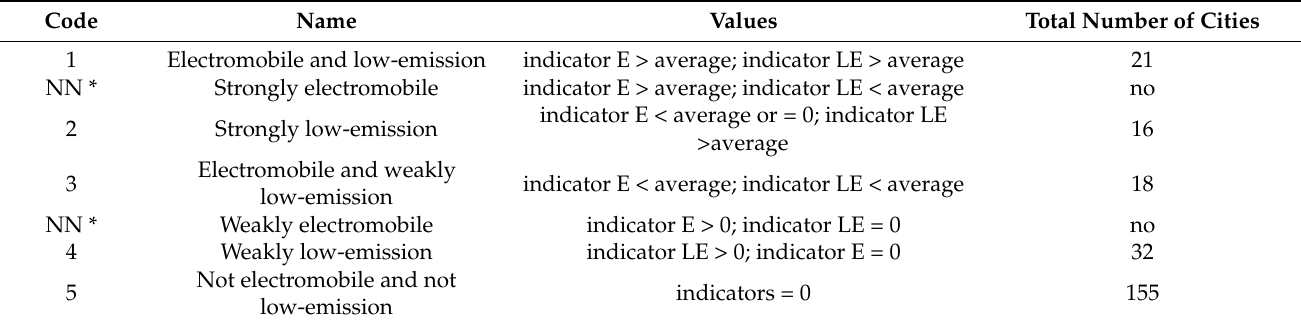
Table 6. Criteria for ranking cities according to electromobility and low-emission transport